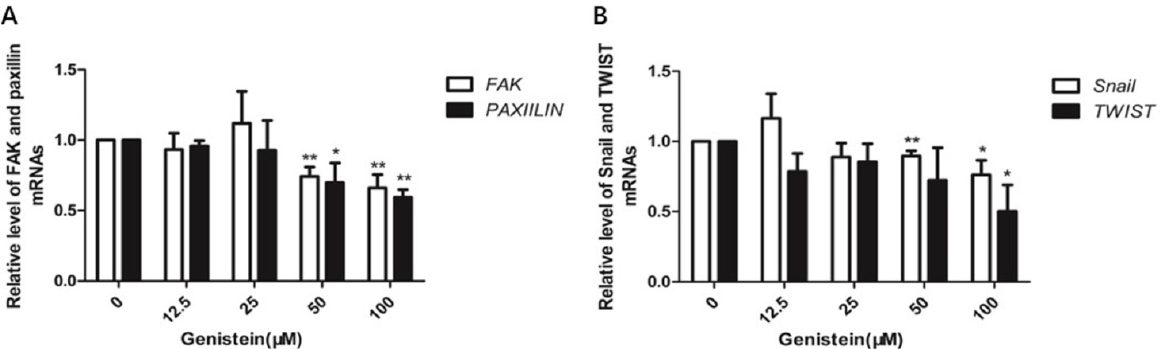
Figure 13. Effect of genistein on specific gene expression in HeLa cells. ( A ) Genistein inhibited FAK and paxillin, and ( B ) Snail and Twist mRNA expression in HeLa cells. Gene expression was